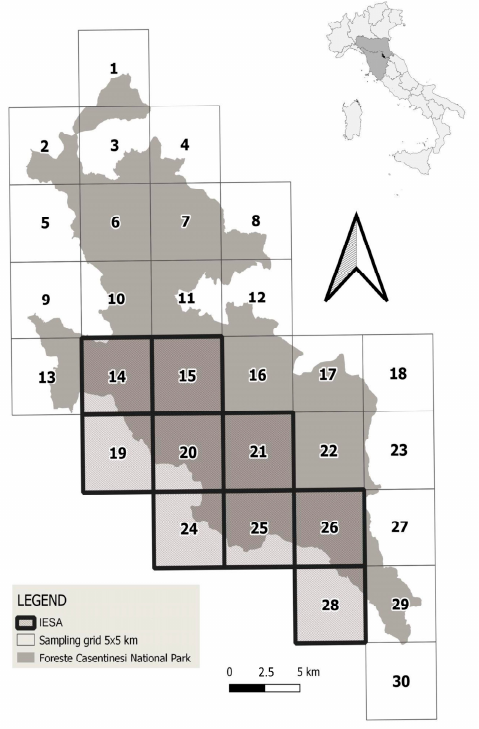
Figure 1. Sampling grid 5 × 5 km across the Foreste Casentinesi National Park in the Northern Apennines, Italy. Cells are numbered from 1 to 30. Increased Effort Sampling Area (IESA) cells are indicated in bold.